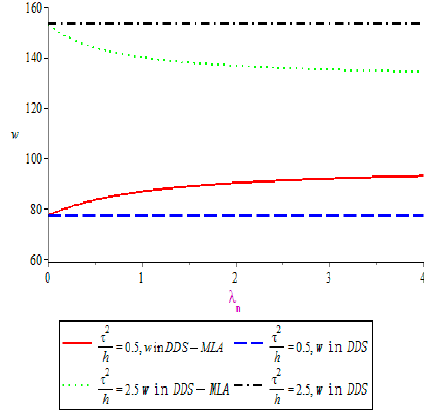
Figure 3. The impact of loss-aversion coefficient on wholesale price.